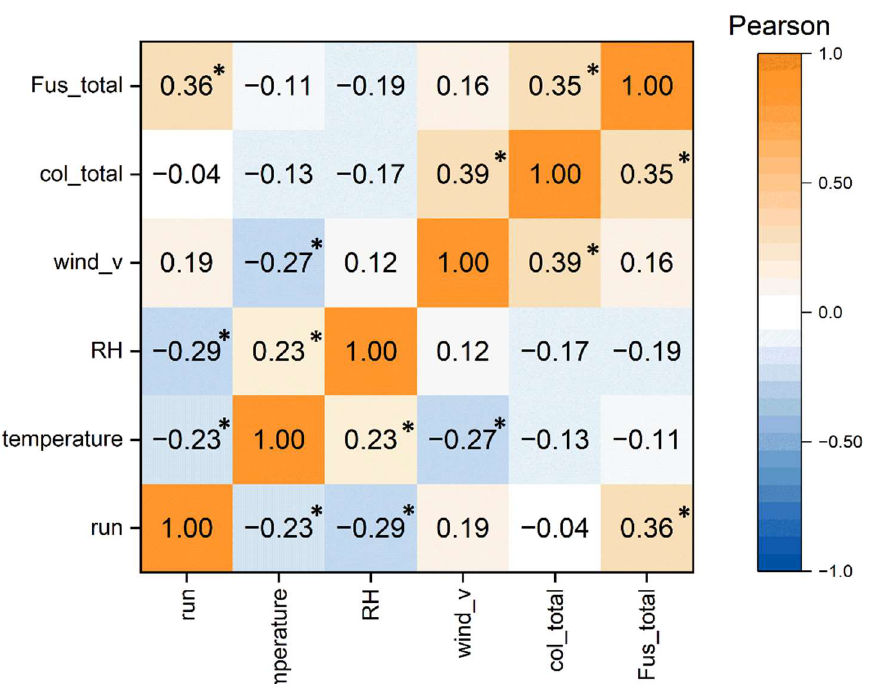
Figure 5. Pearson correlation matrix between time, abiotic parameters such as temperature and relative humidity in the wind tunnel, the wind speed, and the number of cfu counted in total and caught Fusarium over the whole experimental period. The Pearson correlation coefficient is a value between +1 and −1, where 0 is no correlation at all. The data from 90 runs (controls and actual dispersal measurements) were processed in the analysis. A two-tailed test of significance was used. *: Correlation was significant at the 0.05 level.